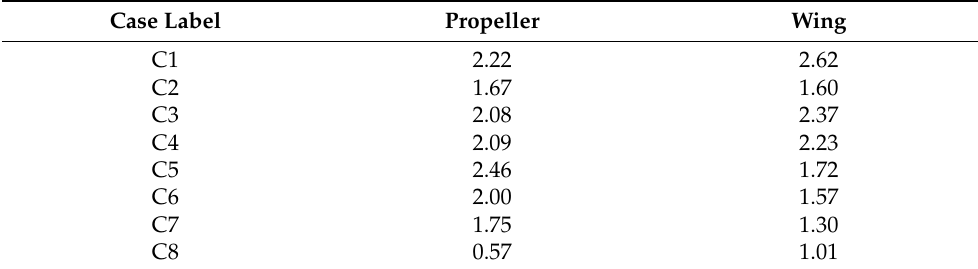
Table 4. Average y + values on propeller and wing for all cases.